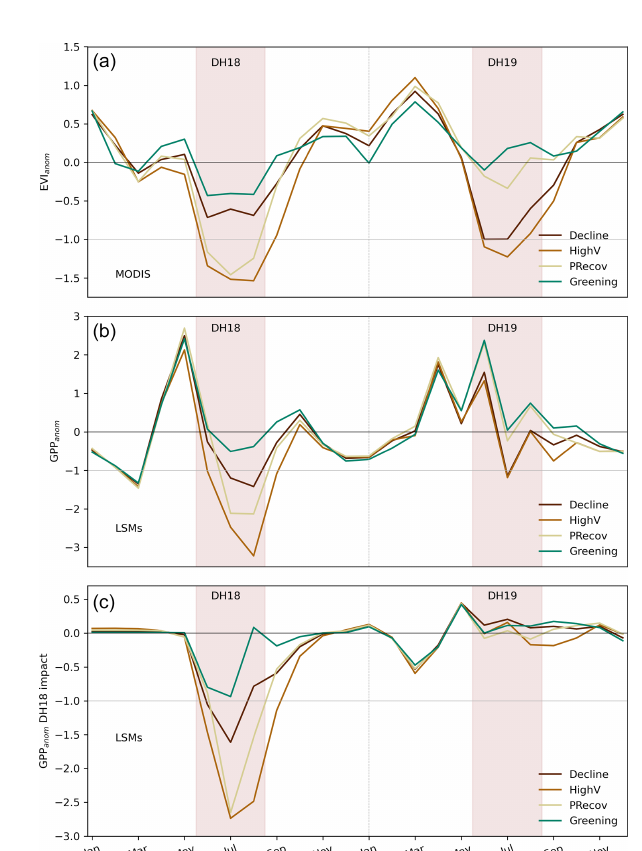
Figure 7. Observed and process-based model simulations of 2018/19 impacts. Seasonal evolution of EVI anom (a) and standard- ised GPP anomalies (GPP anom , b ) over the 2-year period for each cluster (defined in Fig. 3 and shown for LSM grid in Fig. B7). Panel (c) shows the difference between the reference and factorial simulations and indicates the impacts of DH18 on GPP anom simu- lated by models during the event and in the subsequent months until December